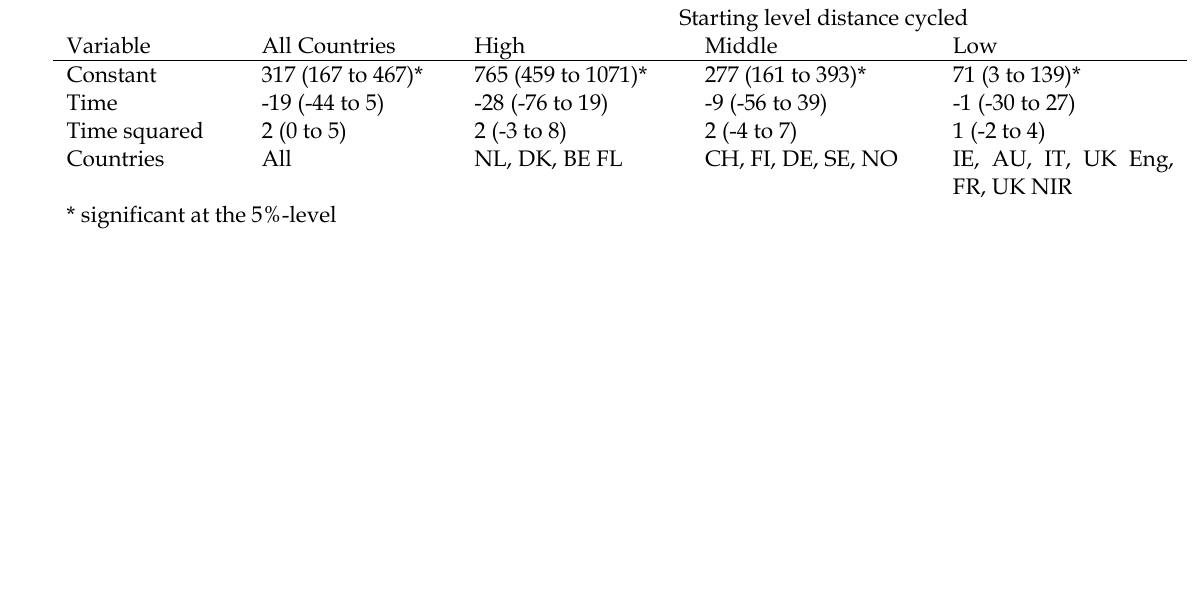
Multi-level regression analyses on distance cycled per capita (95%